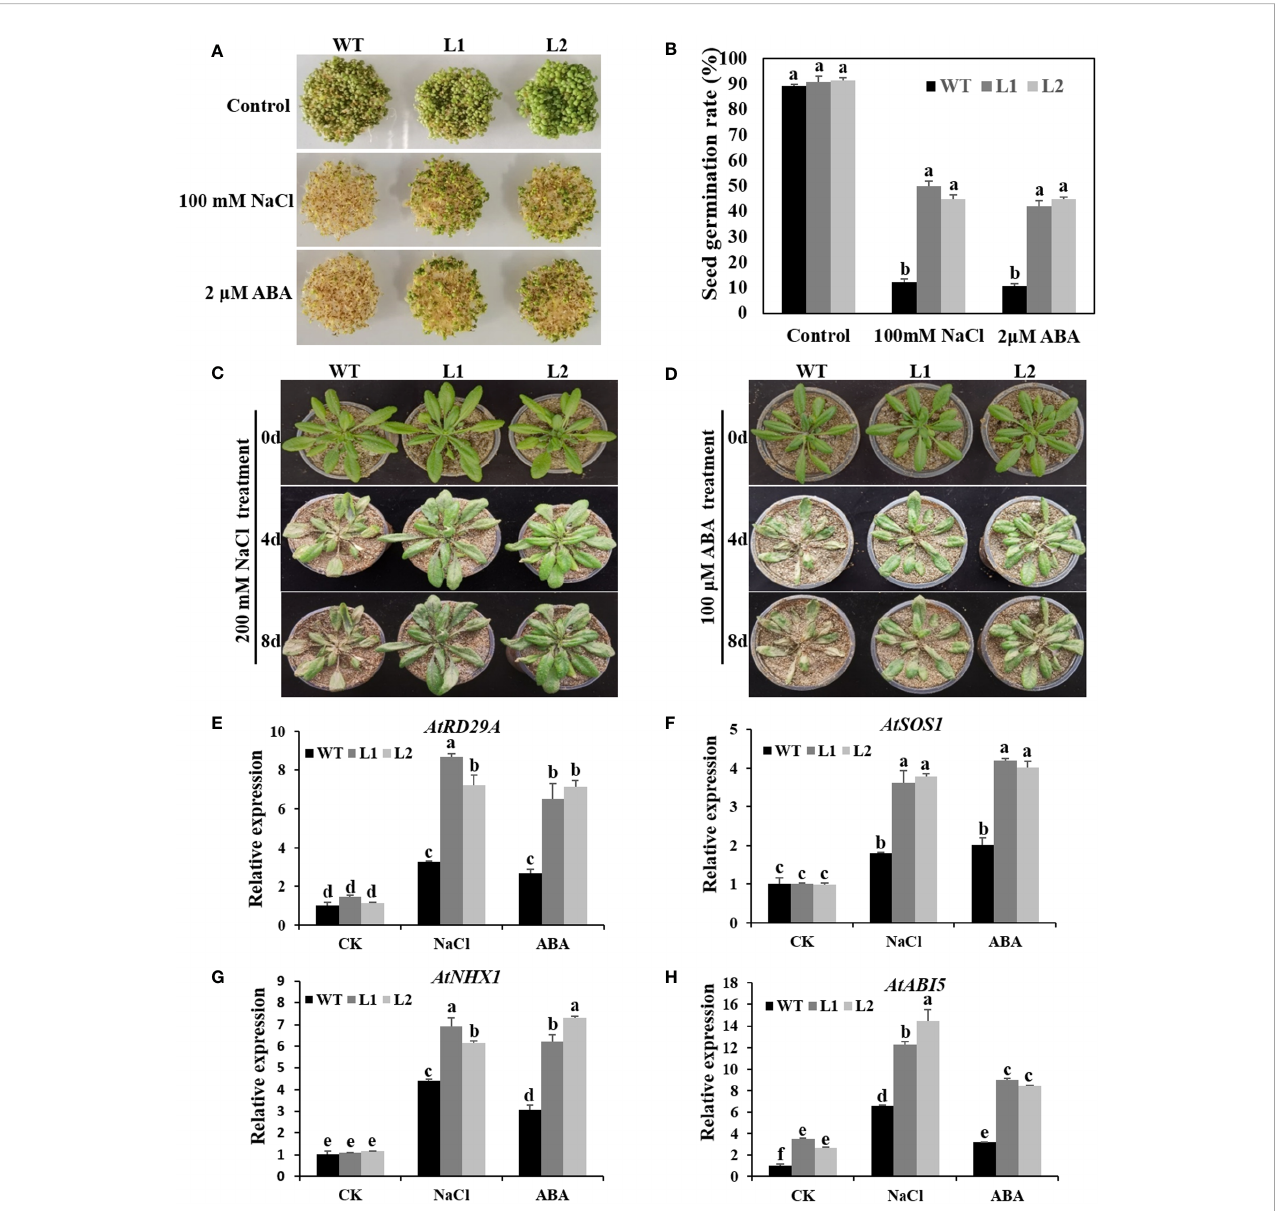
FIGURE 8 CsRAV1 enhanced NaCl and ABA tolerance in transgenic Arabidopsis . (A) Seed germination of WT and 35S : CsRAV1 plants (L1 and L2) after 7 d on 1/2 MS with NaCl and ABA. (B) Seed germination rate in (A) . Different letters indicated signi fi cant differences (P < 0.05). (C, D) Phenotypes of WT and 35S : CsRAV1 transgenic plants treated with NaCl and ABA. After 6 h of NaCl and ABA stress treatment, the expression levels of stress- and ABA- related marker genes AtRD29A (E) , AtSOS1 (F) , AtNHX1 (G) , and AtABI5 (H) were detected in WT and 35S : CsRAV1 plants (L1 and L2). The actin gene was used as internal control, with error bars of three biological replicates. Different letters indicated signi fi cant differences (P <